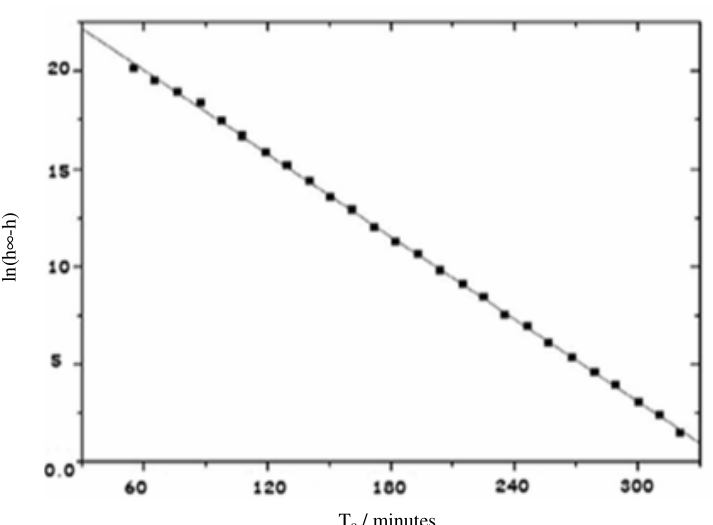
Figure 5 . Example of plotting Eq. 20 for the diffusion of liquid vapour ( n -hexane) into carrier gas at 313.15 K and 1atm ( v =1.0 cm 3 s -1 ) From the slope of this plot, which is equal to -2(k L+D)/L 2 , according to Eq. 20, using o the theoretically calculated value for D from Fuller-Schettler-Giddings equation 20 and the actual value of L, a value of k was calculated. This approximate value is now used to be c plotted according to Eq. 21 as shown in Figure 6.